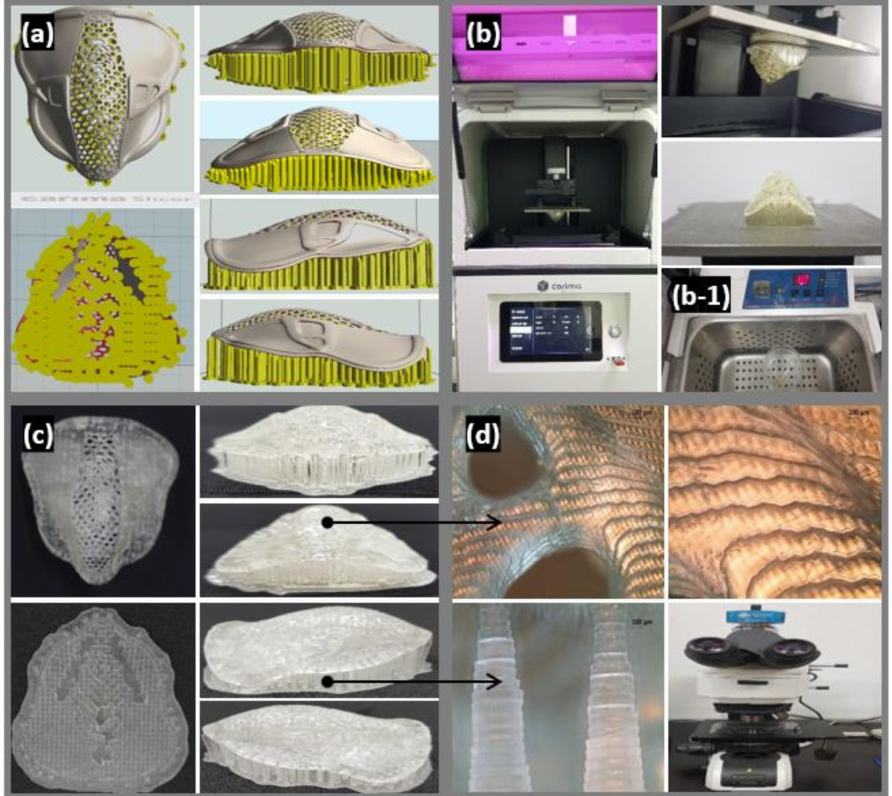
Figure 4. DLP (Digital Light Processing) 3D printing process using PA-APU based resin: ( a ) slicing of target mask structure by the Carima slicer, ( b ) successive photographs of 3D mask printing using DLP (Digital Light Processing) method, ( b-1 ) cleaning process, ( c ) the whole completed 3D mask, ( d ) microscopy images of internal surface in a 3D mask.